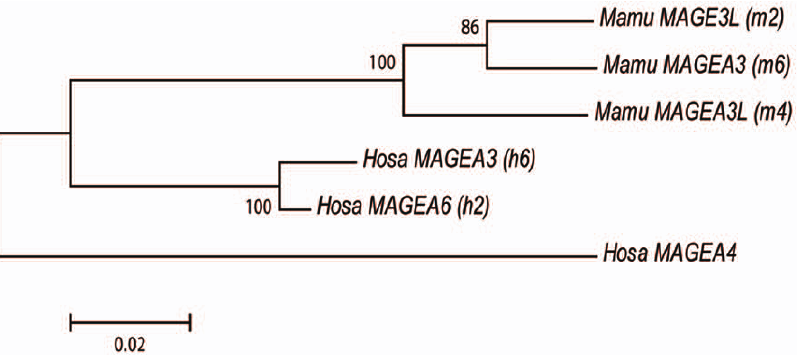
Figure 8. The phylogeny of six MAGE-A genes from humans and macaques. The NJ tree was based on synonymous divergences among six MAGE-A CDSs. The number of sites compared is 314. The root is determined by MAGE-A4 .